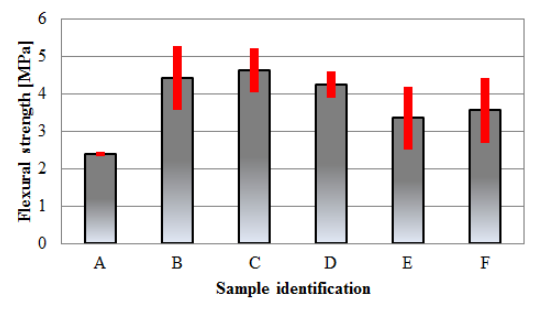
Figure 4. Flexural strength of the samples.